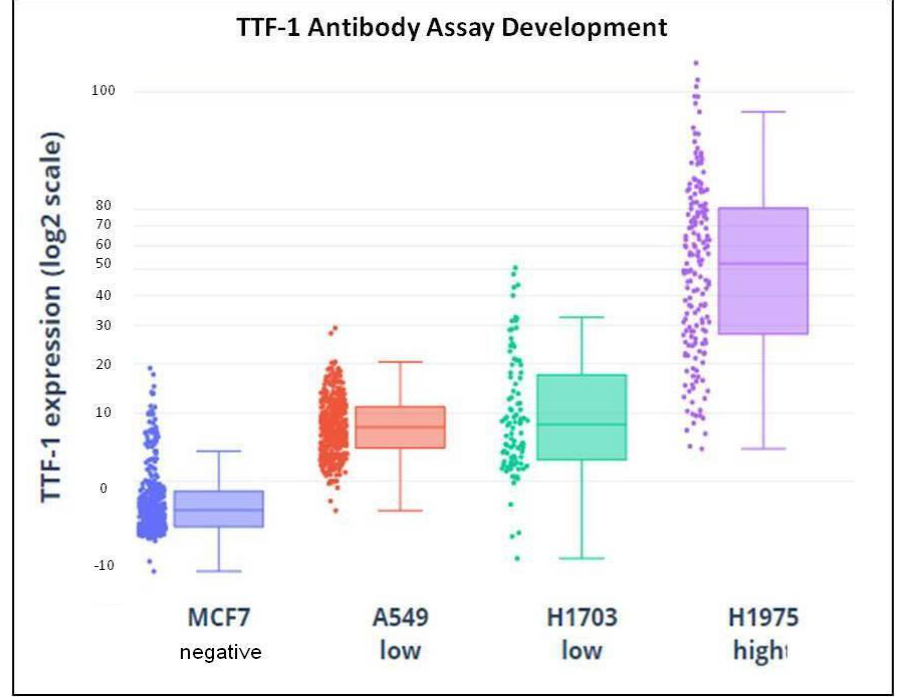
Figure 3. Demonstration of TTF-1 assay specificity: TTF-1-specific antibody was tested in negative MCF7 (breast cancer), low A549 and H1703, (lung ADC and lung squamous cell carcinoma, respectively) and high H1975 (lung ADC) TTF-1-expressing cell lines. Individual cellular TTF-1 immunofluorescence signal is quantified and plotted. No specific staining was seen in negative control cell lines. TTF-1, thyroid transcription factor-1; ADC, adenocarcinoma.